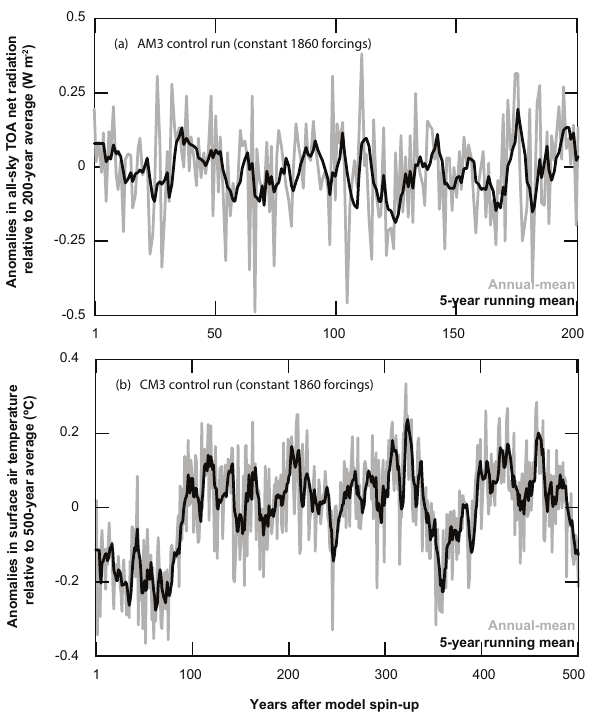
Figure 2. Anomalies in (a) all-sky top-of-the-atmosphere (TOA) net radiation (Wm − 2 ) with respect to the 200-year mean of the con- trol simulation of AM3 and (b) surface air temperature ( ◦ C) with respect to the 500-year mean of the control simulation of CM3. For both panels, pre-industrial (1860) forcings are held constant post-spin-up. Fluctuations indicate unforced variability. Results are shown for annual averages (grey line) and 5-year running means (black line).